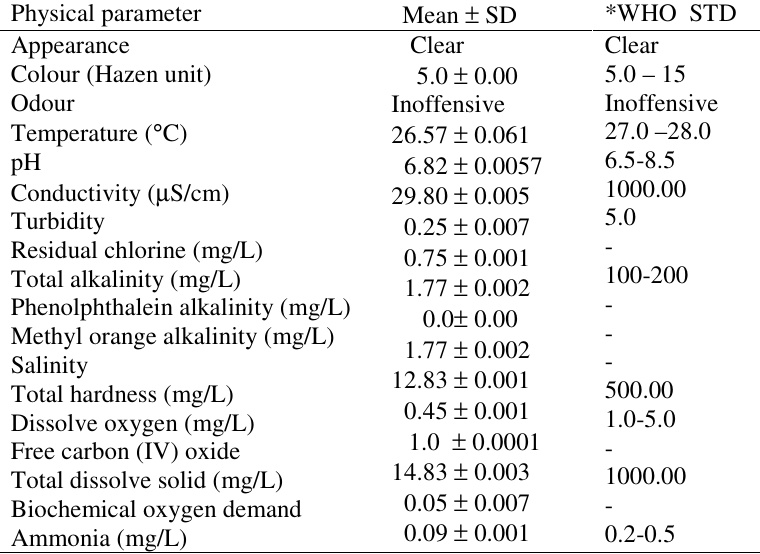
Table 2 . Physiochemical parameters of treated pipe borne